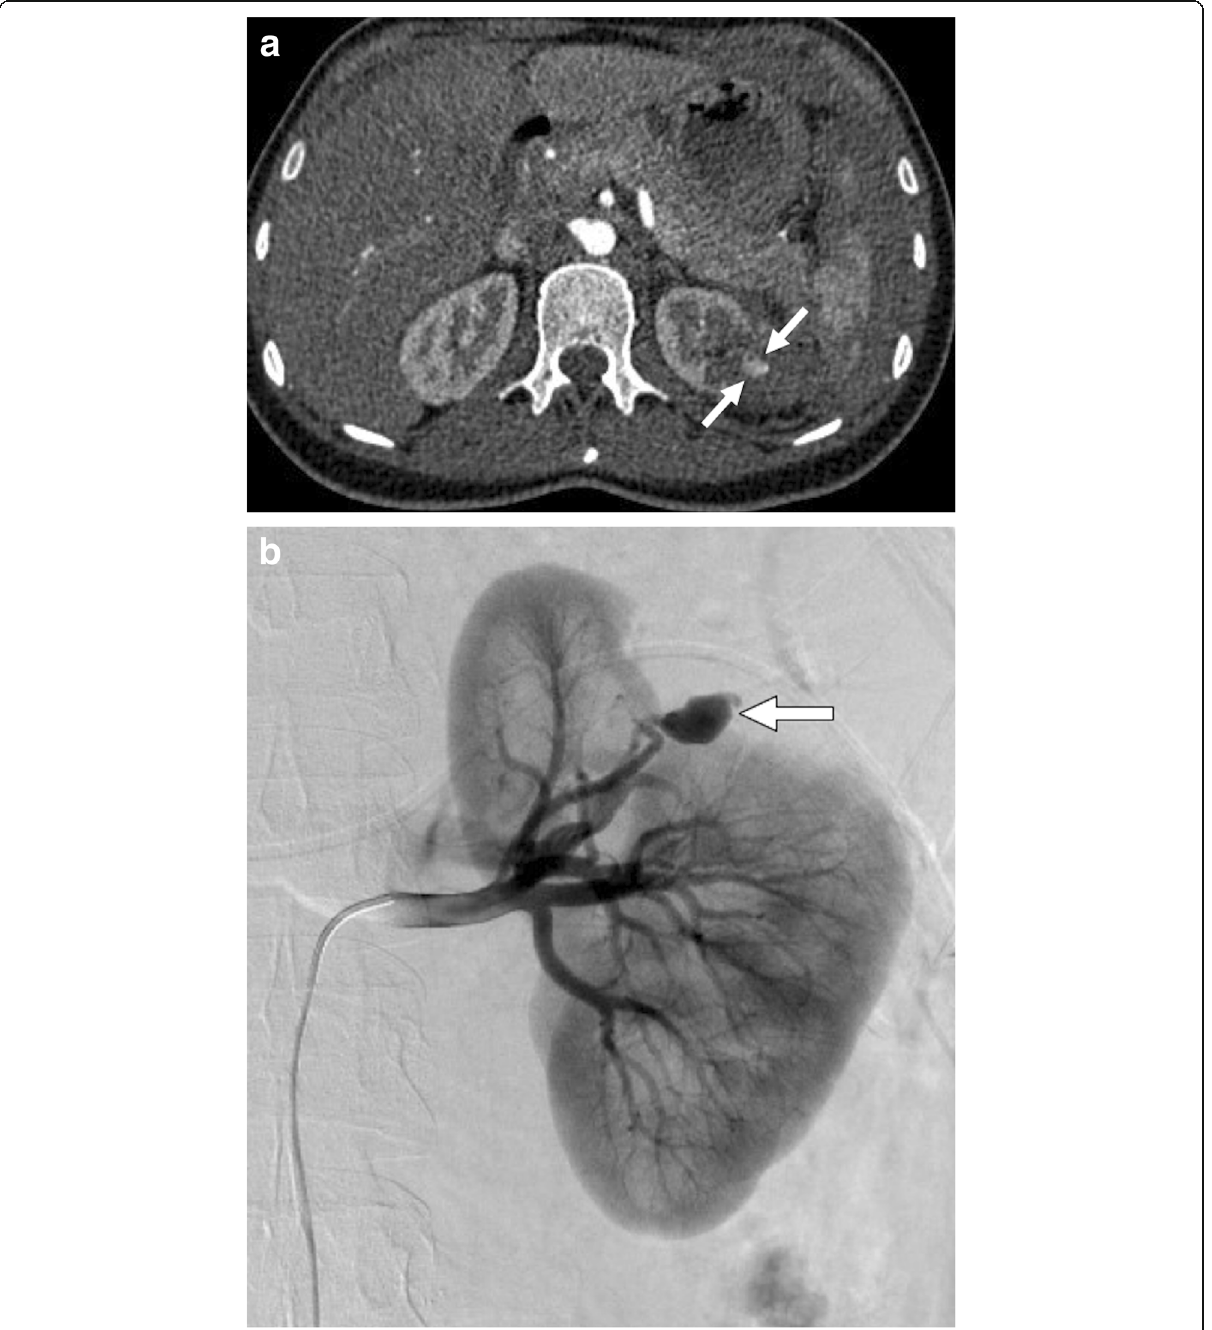
Fig. 14 Renal artery pseudoaneurysms. A 36-year-old female underwent partial nephrectomy for low-grade RCC presented to ED with left flank pain and hematuria 12 days after the surgery. a Axial post-contrast arterial phase CT image shows a small pseudoaneurysm (arrows) at the resection bed. There was also a hematoma surrounding the pseudoaneurysm. b Selective left renal artery catheter angiography clearly demonstrated the pseudoaneurysm (arrow). The pseudoaneurysm was successfully treated with detachable coils in the same